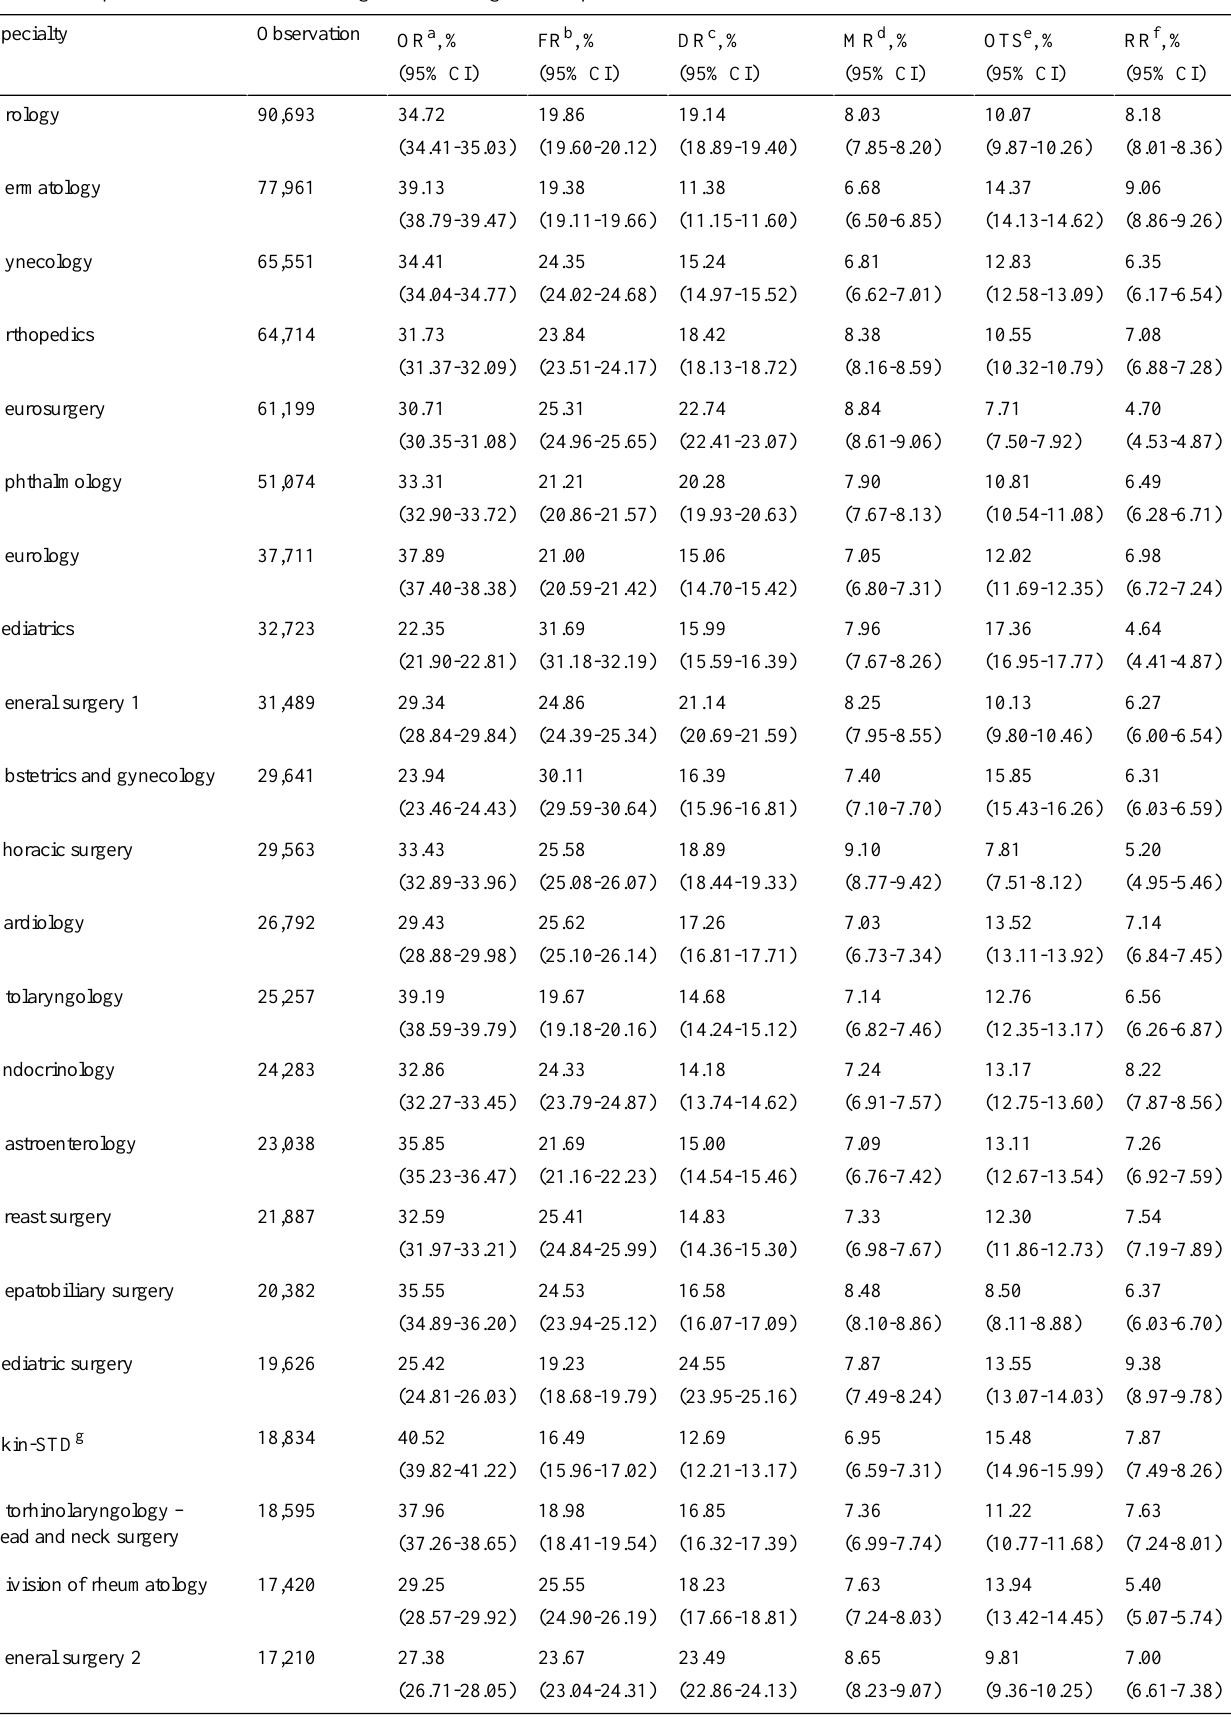
Table 3. Comparison of reasons for choosing doctors among various